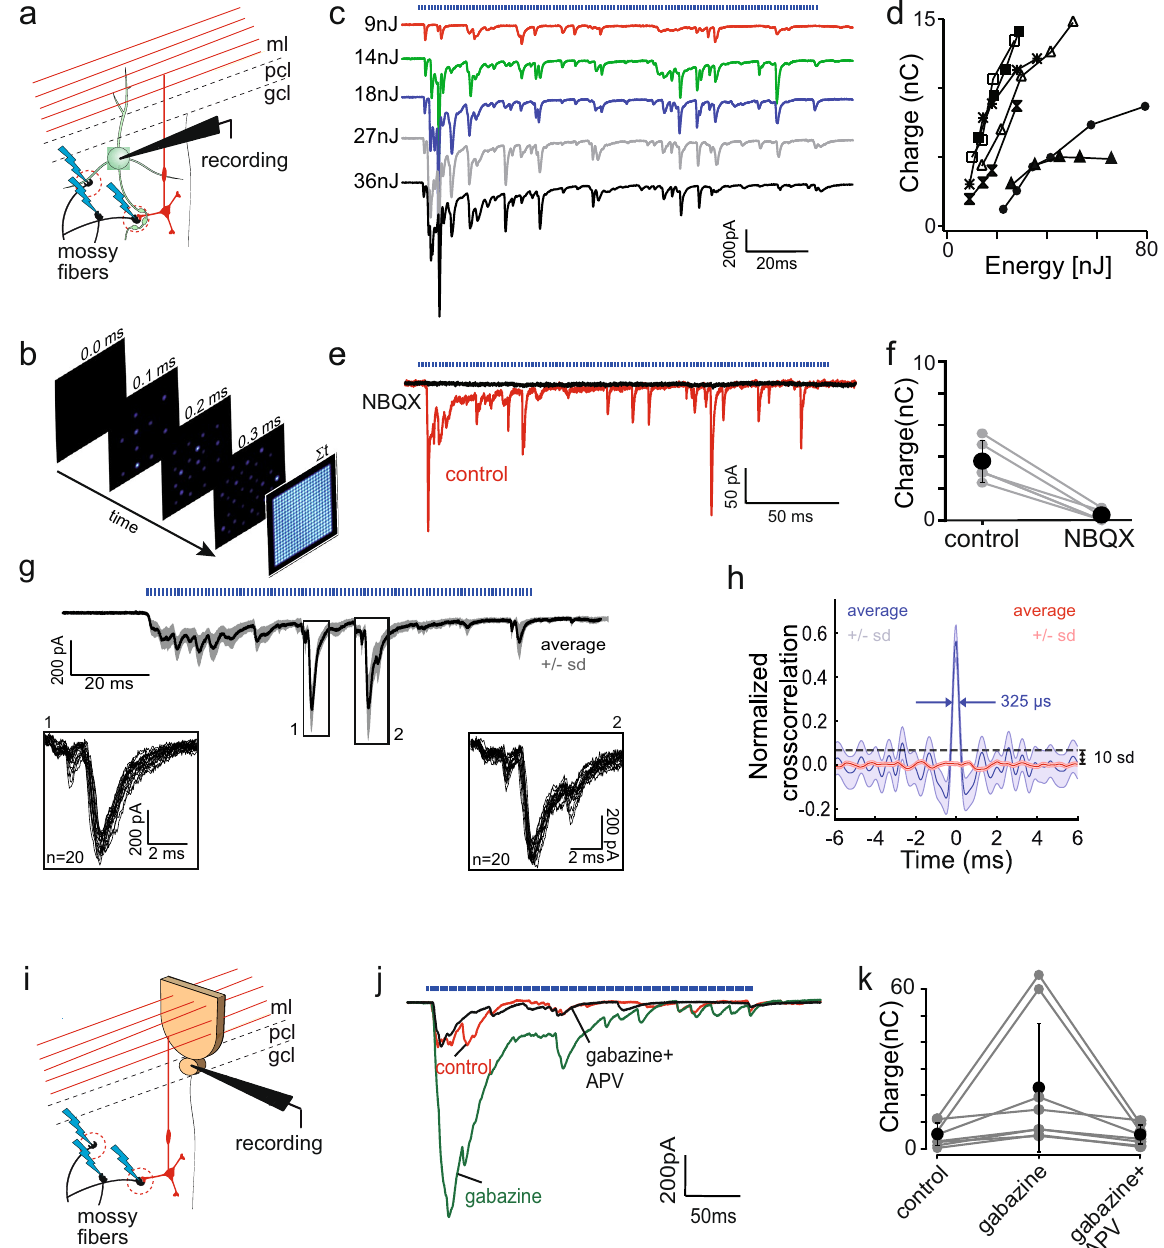
Figure 5. Optogenetic emulation of sensory-motor activity. ( a ) Cartoon showing experimental configuration. Golgi cells in the Thy1-ChR2-YFP vermal slices were recorded in the whole-cell, voltage clamp configuration; optical, asynchronous stimulation, governed by our optimized spatiotemporal light patterns (see Methods), was applied to the field of view surrounding the recorded cell. Blue lightings represent light stimulation. ( b ) Cartoon explaining scanning mode; currently scanning point is represented by the spot with the red filling and fainter points show previous stimulation placement. The last square (farthest right) shows the grid of points covering the whole FOV. ( c ) Recruitment of currents evoked by the asynchronous optogenetic stimulation for 145 ms in one cell (blue trace represents the onset and duration of the stimulation). Energy of each stimulation indicated on the left of each trace. Colors are used only for better visualization of single traces. ( d ) Summary of the charge carried during light stimulated pattern recorded in Golgi cells as a function of energy (n = 7); markers represent different cells. ( e ) Evoked responses are blocked by NBQX (2 µ M), an AMPA receptor blocker. Example of average trace in control (red trace) and after application of NBQX (black trace), showing disappearance of the light evoked events. ( f ) Summary of charge carried during light stimulation in control and with the presence of NBQX; black dots represent the average with error bars of ± s.d., grey traces represents the results for single cell. ( g ) Evoked responses are reliable across many trials with the same energy. The example trace showing the average of 50 traces, with (very narrow) shaded area representing ± s.d. Blue pattern above the traces represents duration of optical stimulation. Each point was stimulated for 0.9 ms with a gap of 100 µ s before